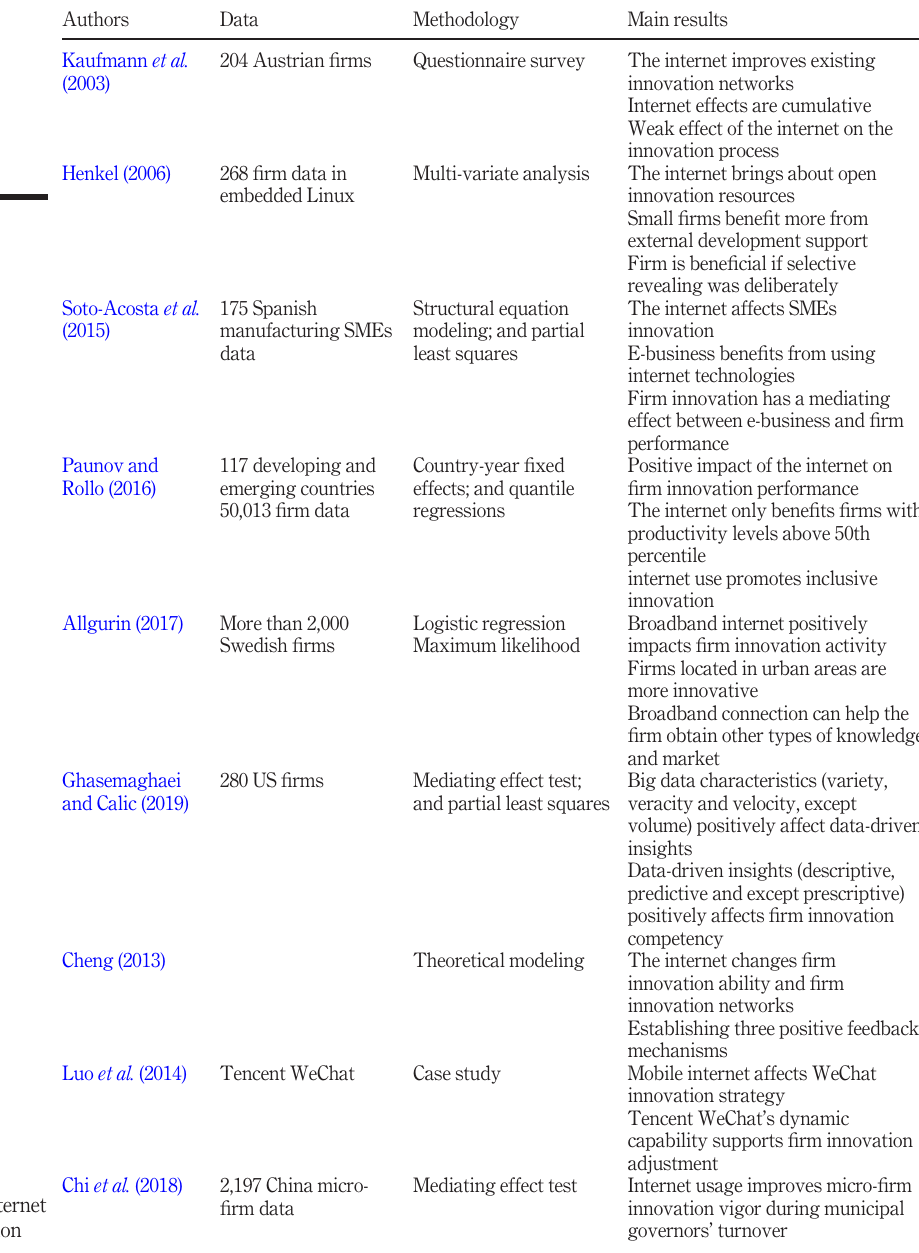
Table I. Effects of the internet on fi rm